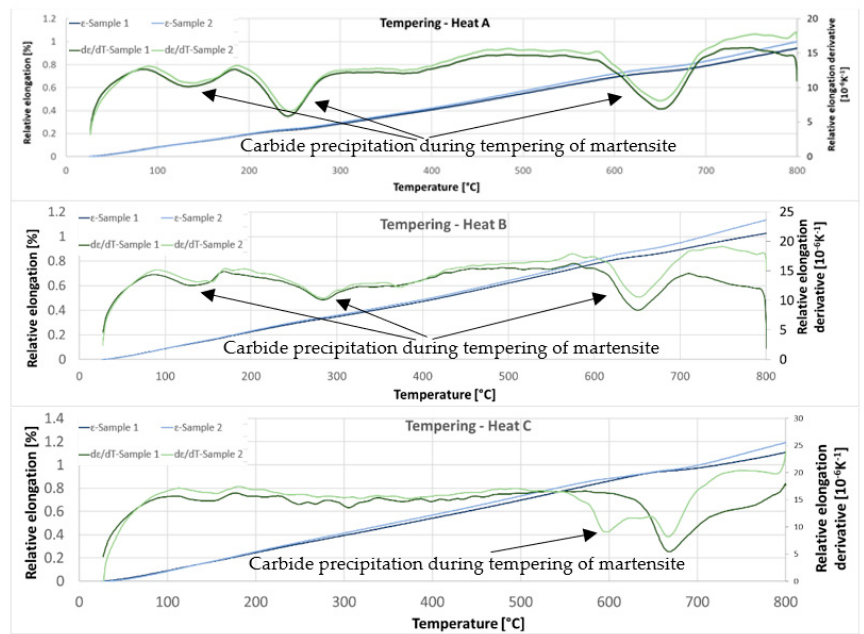
Figure 17. The dilatometric curves of relative elongation and derivative of relative elongation during tempering—heating 3 °C/min.